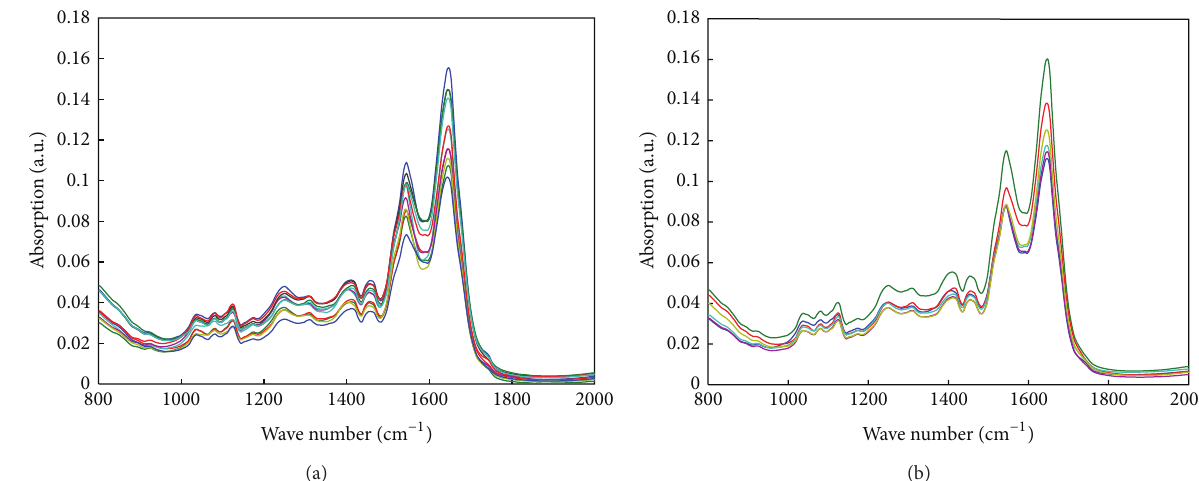
Figure 1: (a) The original spectra of the training set and (b) the original spectra of the test set.